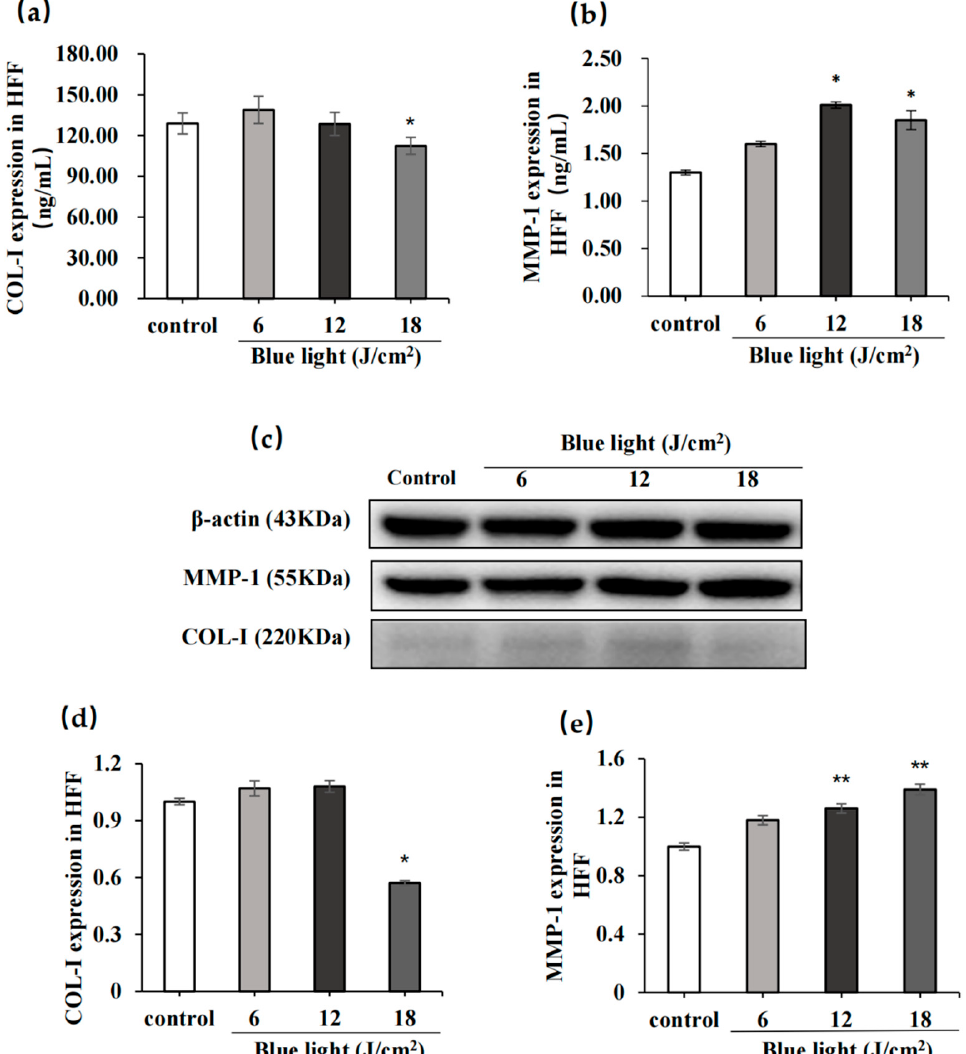
Figure 4. Results of the enzyme-linked immunosorbent assay (ELISA) and Western blotting (WB) experiments on HFF cells. ( a , b ) ELISA results after detecting collagen (COL-I) and metalloproteinase 1 (MMP-1) secretion levels in HFF cells under three blue light doses. ( c – e ) Level of COL-I and MMP-1 secretions in HFF cells under three blue light doses, from a WB assay. The data are expressed as mean ± standard deviation (SD) of three independent experiments ( n = 3). The data were analyzed using one-way analysis of variance (ANOVA) followed by Tukey’s test. * p < 0.05; ** p < 0.01, vs. control